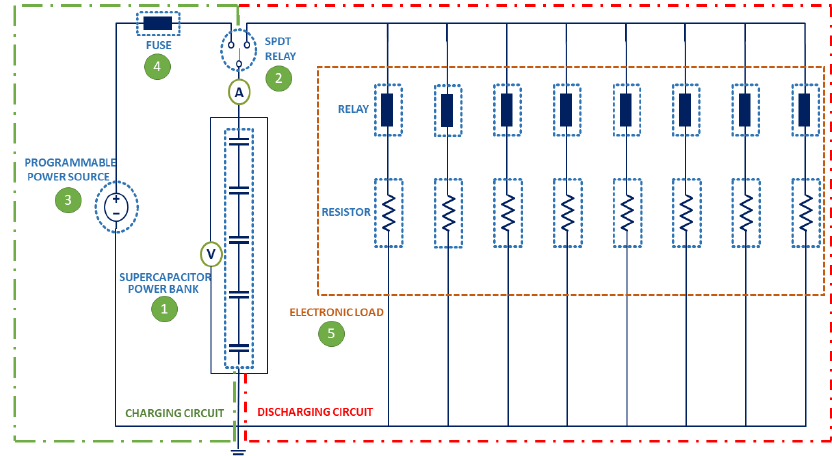
Figure 7. Supercapacitor test bench. Electrical layout.